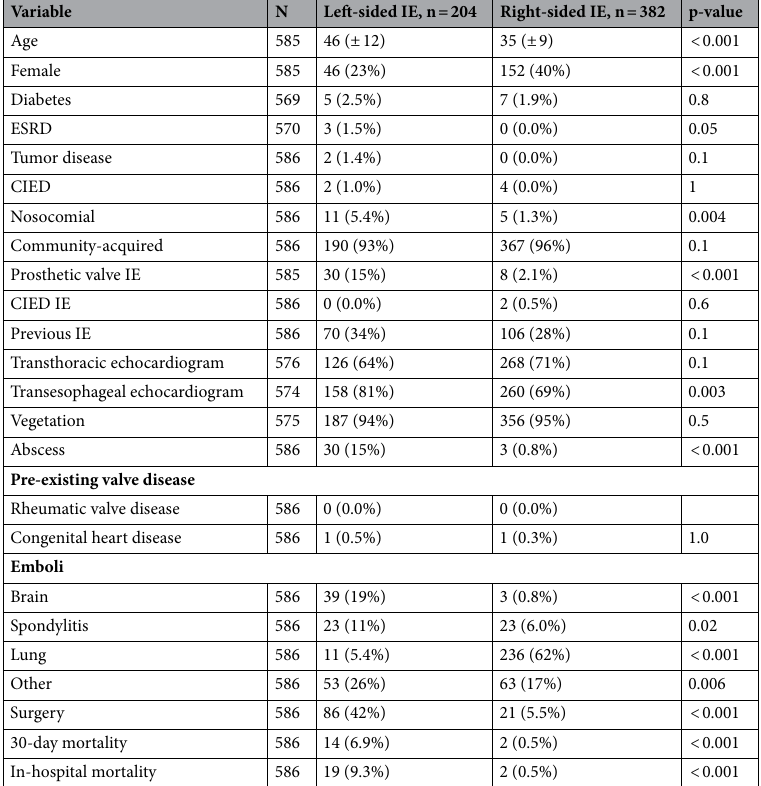
Table 1. Patient characteristics in IVDUs. N represents the total number of responses in each variable. Continuous variables (normally distributed) are presented as mean with standard deviation in parenthesis. Dichotomous variables are presented as number of cases with percentage in parenthesis. Diabetes includes both type 1 and type 2. There were 17 missing responses for diabetes in total. ESRD had 16 missing responses in total. ESRD end-stage renal disease, CIED cardiovascular implantable electronic